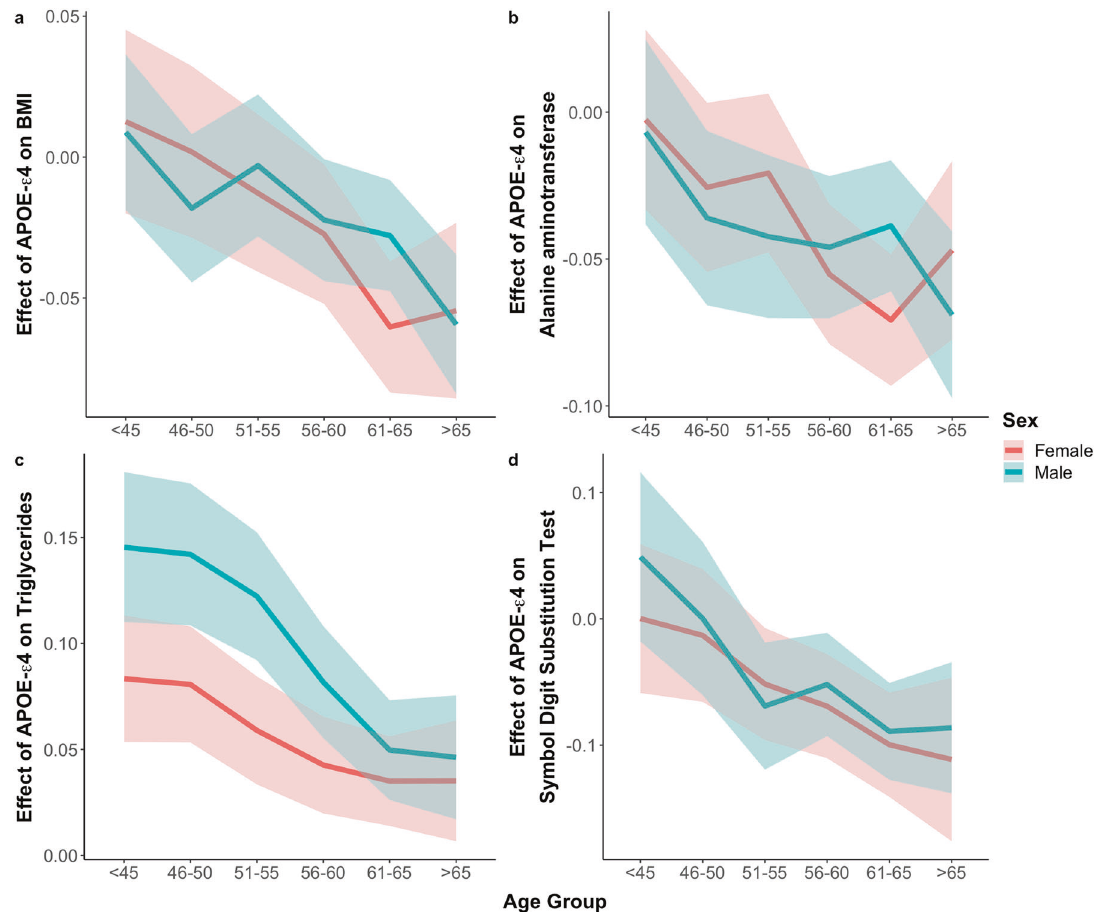
Fig. 5 Effect of APOE- ε 4 across different age groups on BMI, Alanine aminotransferase, Triglycerides and the Symbol Digit Substitution Test. Analyses are performed strati fi ed by sex. The shaded area corresponds to the 95% con fi dence interval. Note that the analysis described in the text involves testing for an APOE- ε 4*age interaction explicitly, with age considered as a continuous variable; the effect size of APOE- ε 4 is estimated in age groups here for visualization of the